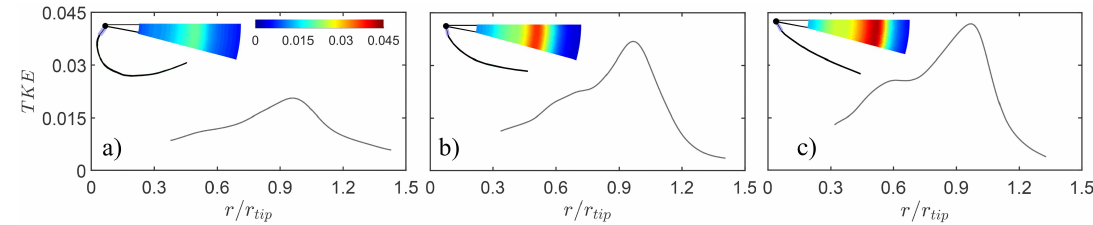
Figure 9. θ —averaged distributions of in-plane normalized turbulence kinetic energy TKE = TKE / ( ω R ) 2 of the different plates at ω = 90 rpm: ( a ) thin; ( b ) medium; and ( c ) thick.